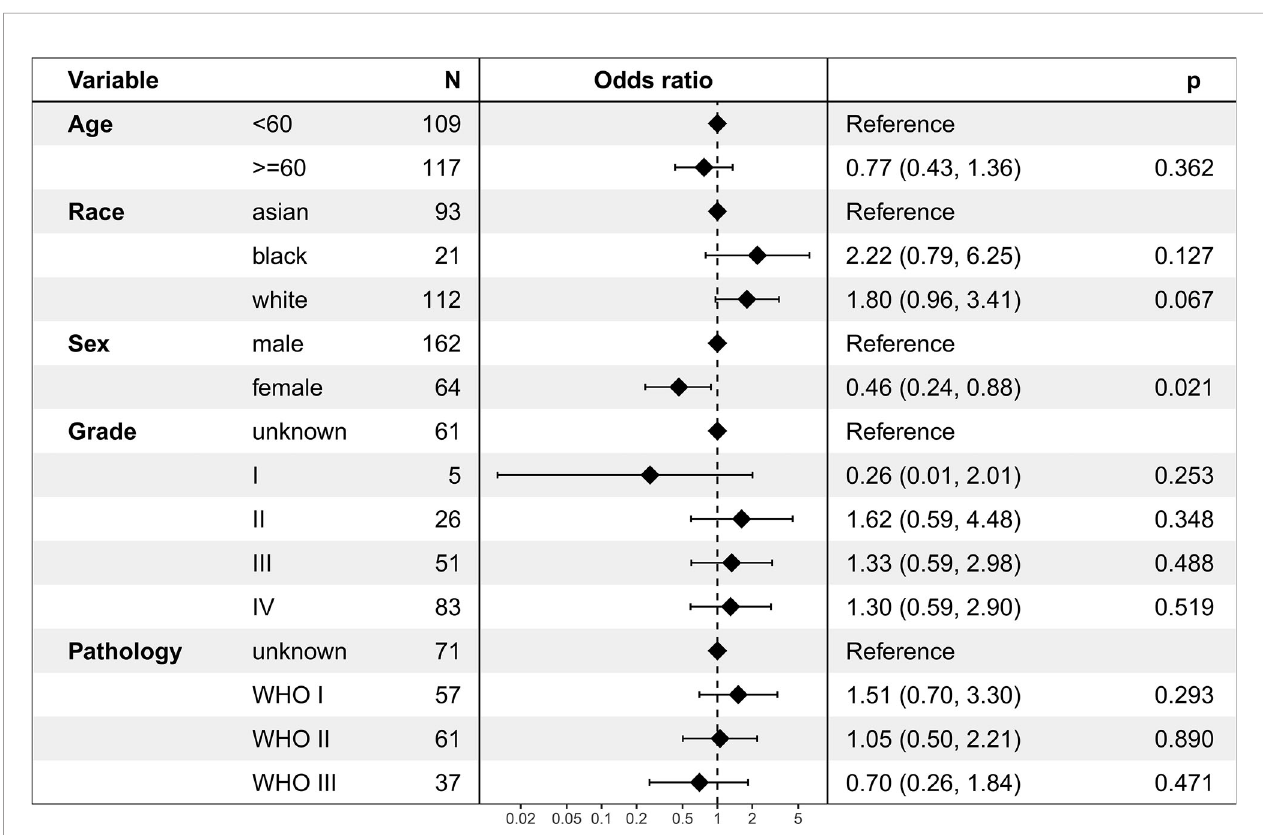
FIGURE 2 | Logistic regression analysis for factors associated with chemotherapy